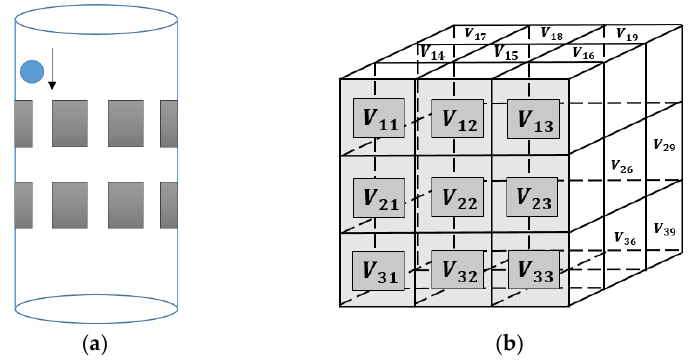
Figure 9. ( a ) The movement of the inclusion in the 3D phantom ( b ) Distribution of 27 voxels within the domain.